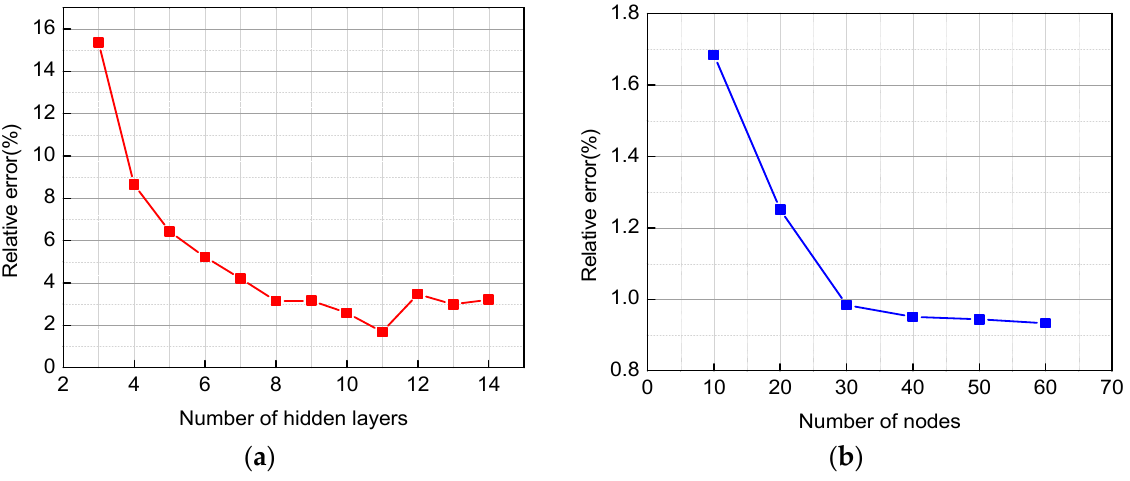
Figure 13. Determination of hidden layer number and node number in the DNN model. ( a ) Error under different hidden layer numbers. ( b ) Error under different node numbers.